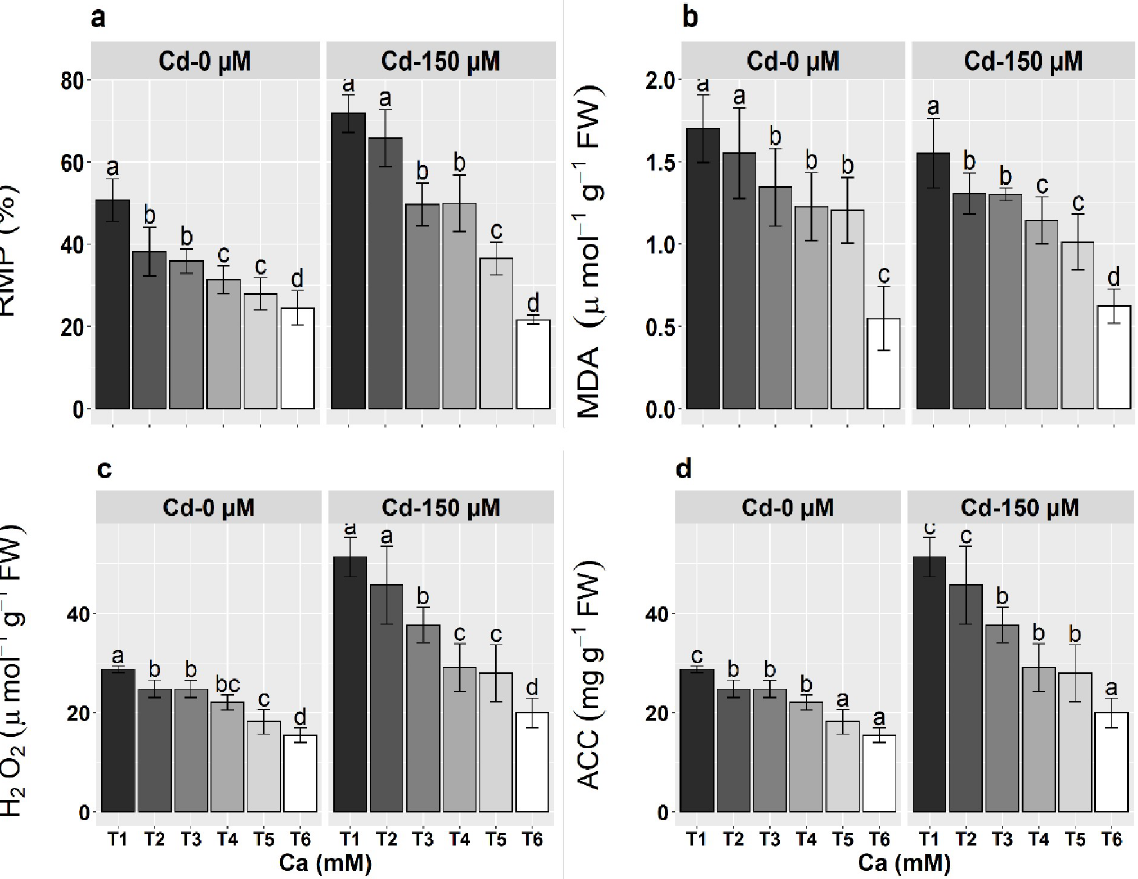
Fig 1. Effect of calcium (Ca; T1-0 m M , T2-0.5 m M , T3-1 m M , T4-2.5 m M , T5-5 m M , T6-10 m M ) and cadmium (Cd) treatments on the a) relative membrane permeability (RMP), b) melanoaldehyde contents, c) H 2 O 2 , and d) anthocyanine contents (ACC) of maize seedlings. Means ± SE provided with error bars; different letter indicates significance ( P � 0.05) between Ca and Cd treatments.